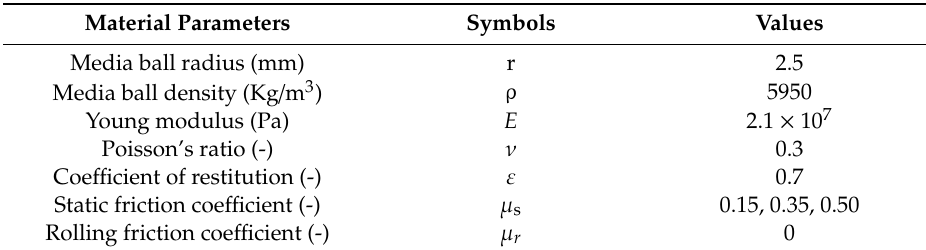
Table 3. DEM input